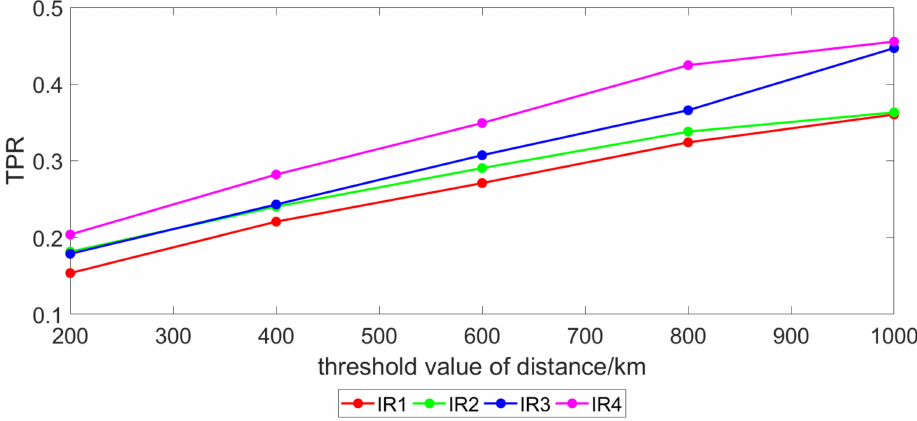
Figure 6. True positive rates in different channels at different distance